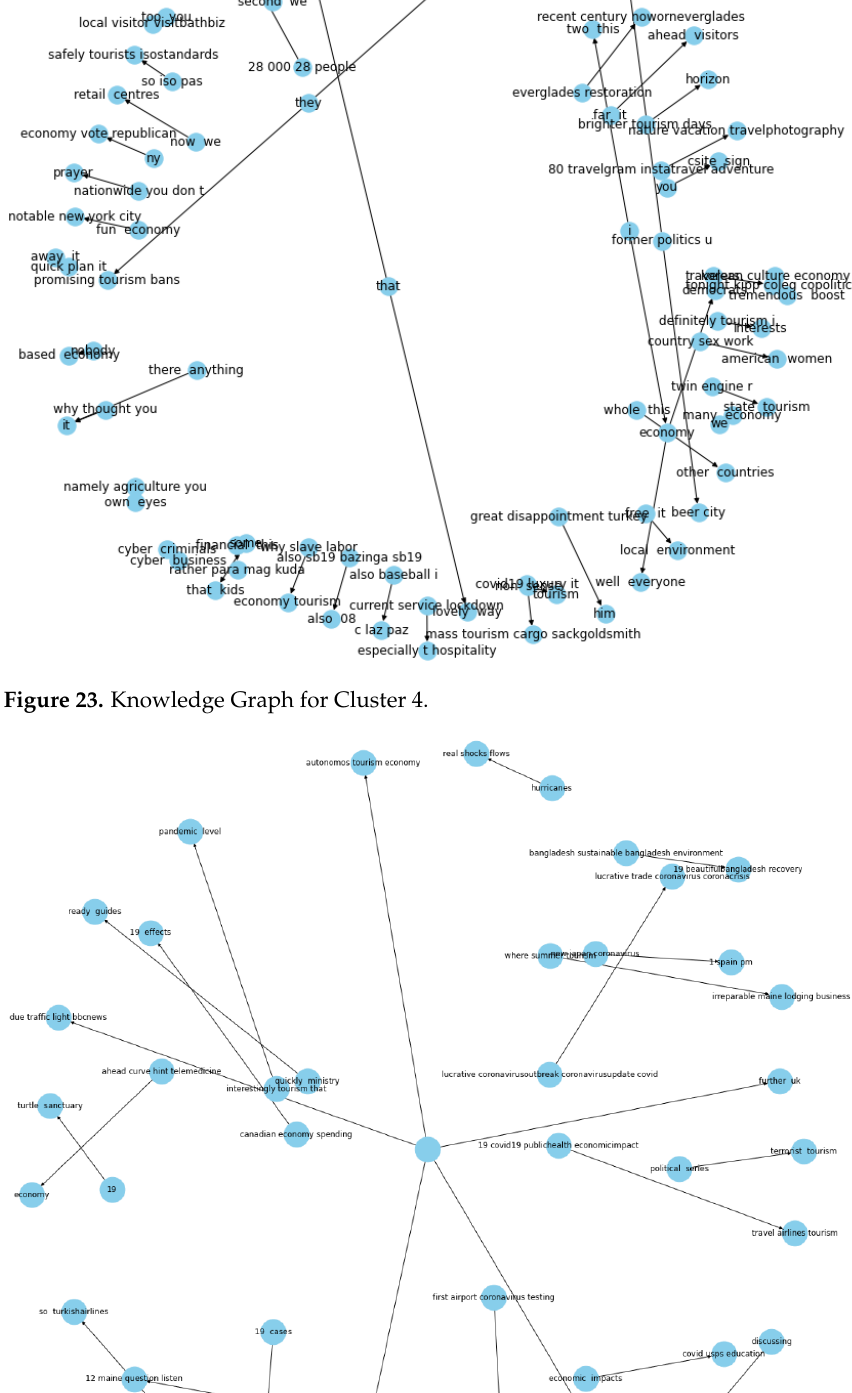
Figure 22. Knowledge Graph for Cluster 3.